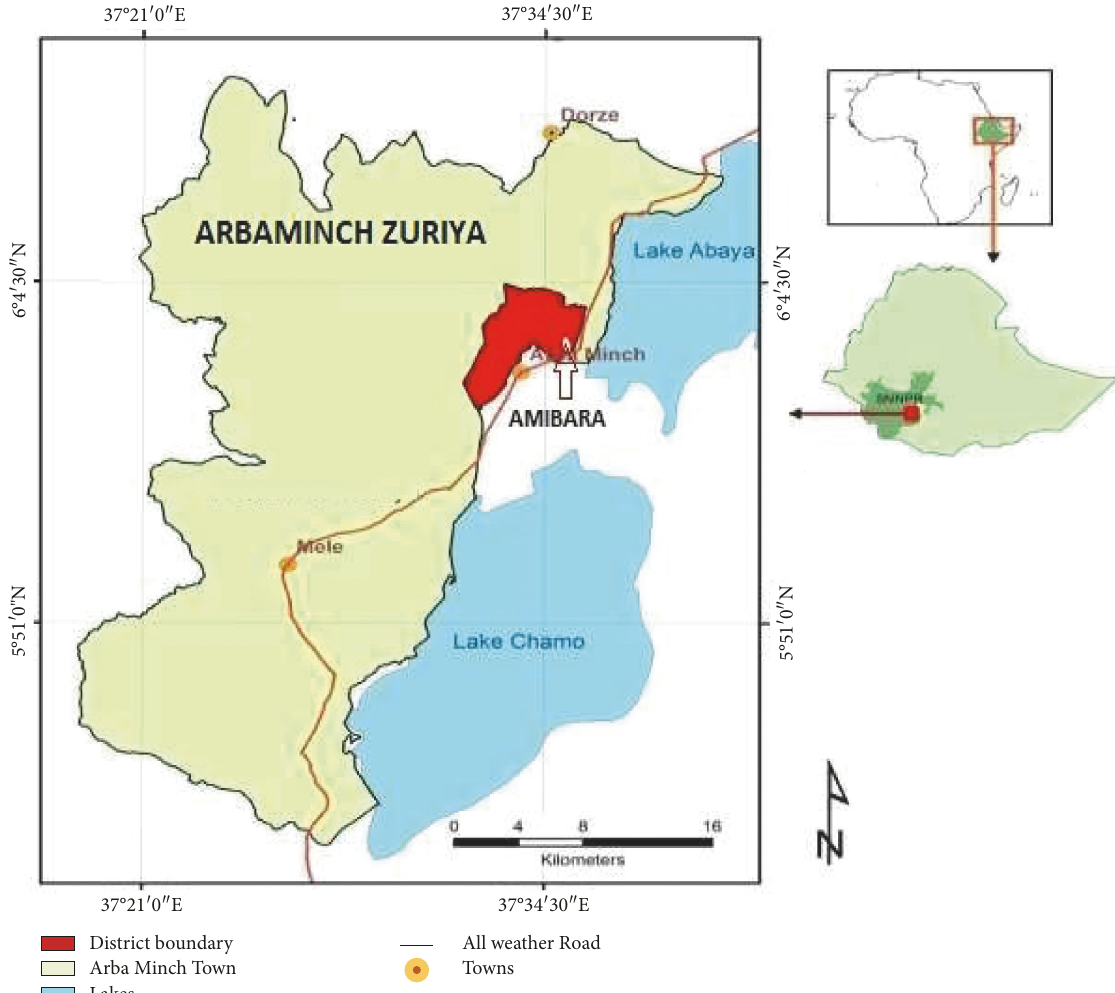
Figure 1: Map of the study area.